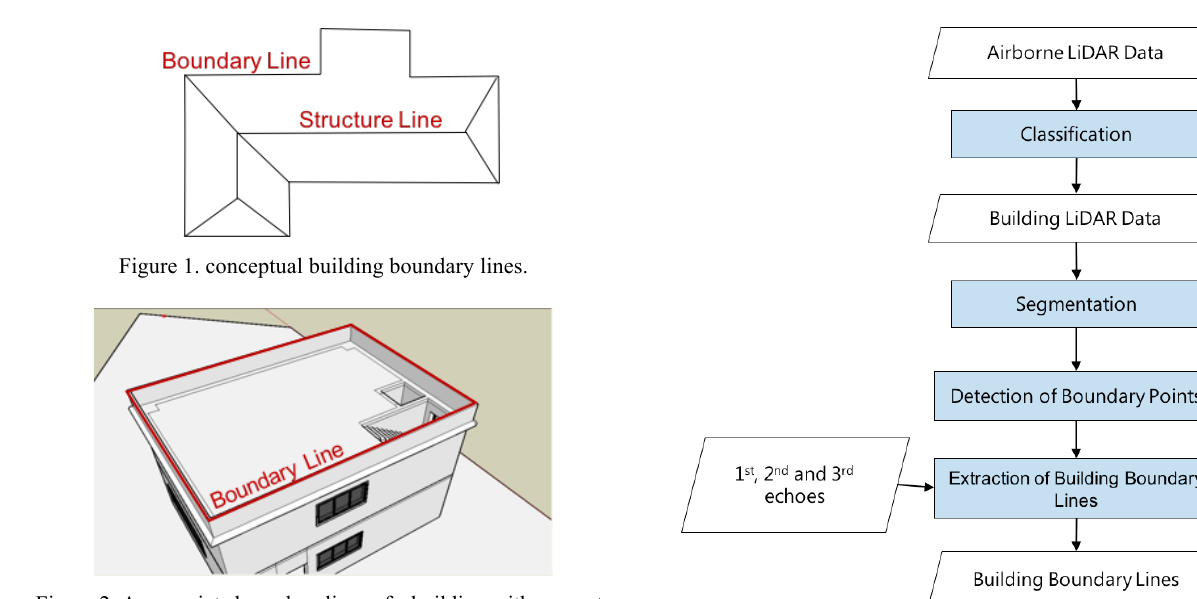
Figure 2. Appropriate boundary lines of a building with parapets on the roof.